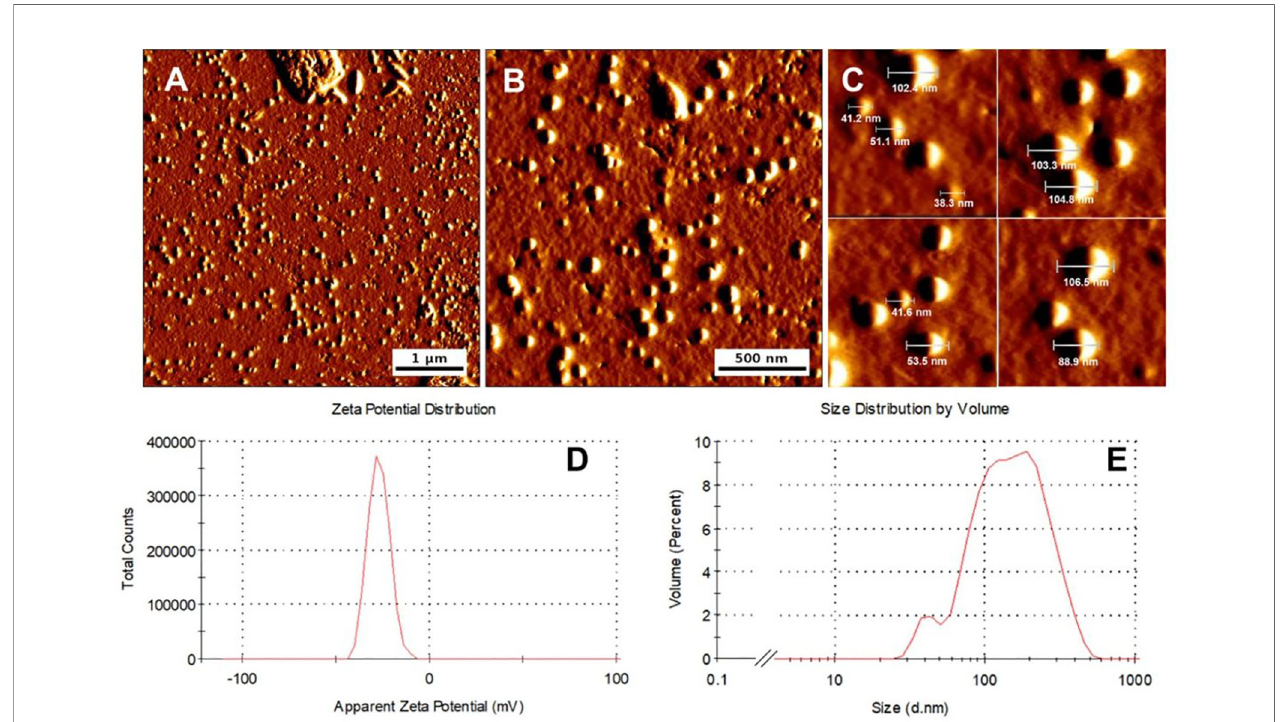
FIGURE 3 | dsRNA40-chol forms nanoparticles by self-assembly. (A – C) Morphology of representative dsRNA40-chol nanoparticles shown by atomic force microscopy. All micrographs are presented in amplitude mode. (D) represents the LDA zeta potential measurements and (E) the size distribution and the diameter of the